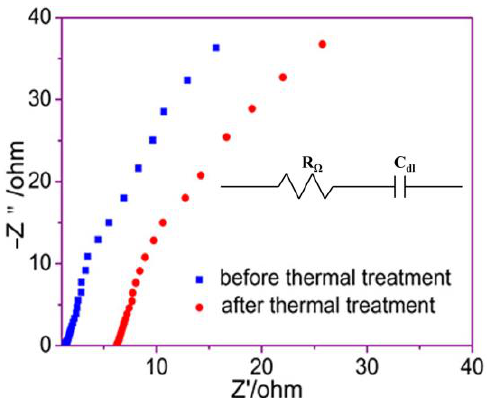
Figure 7. AC impedance spectra of fiber membrane before and after thermal treatment.